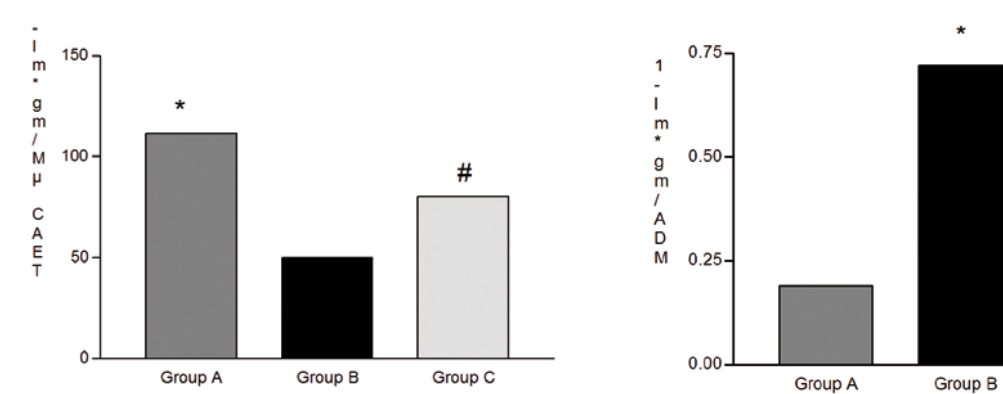
Figure 2 - Mean MDA values of the samples obtained from the rats, in the different